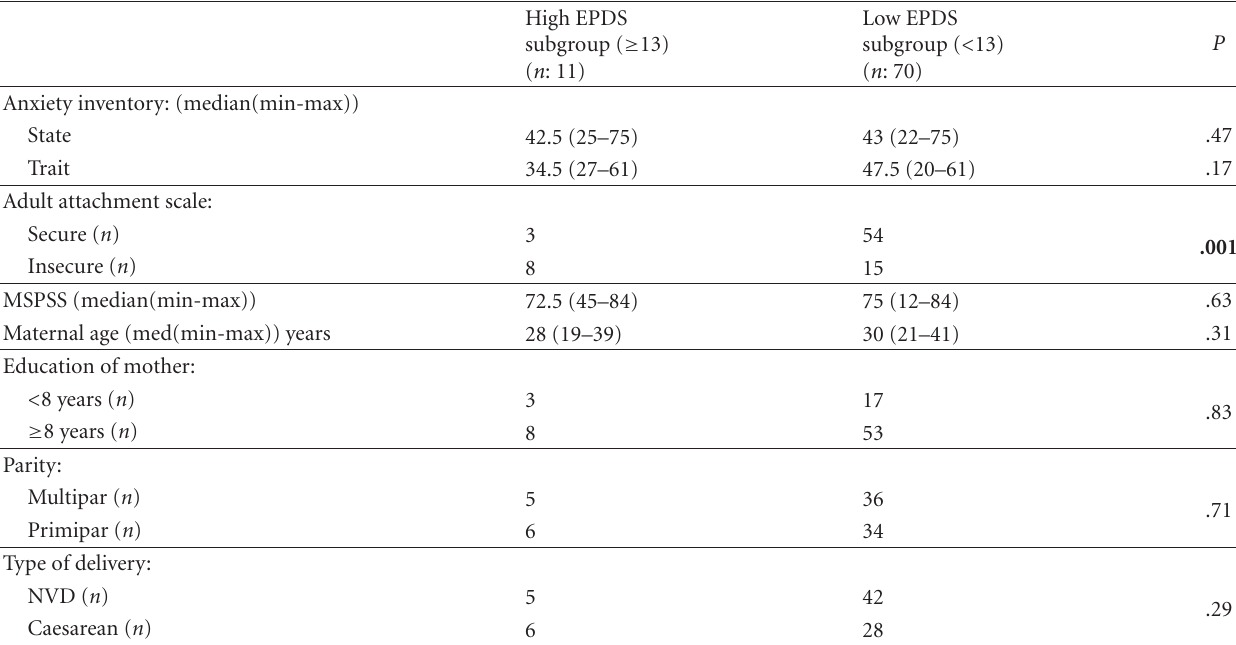
Table 5: Psychological adjustment and demographic characteristics of control subgroups according to the EPDS scores. High